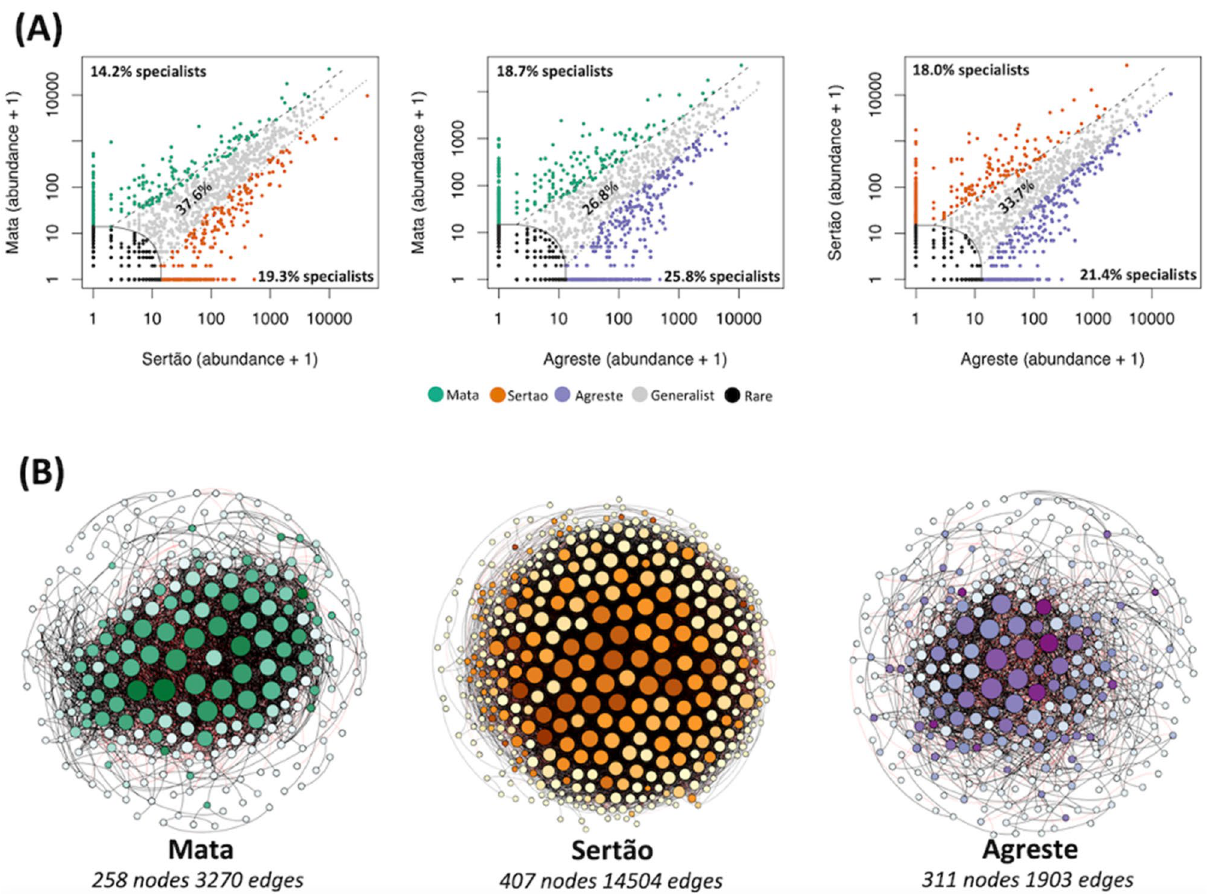
Figure 5. ( A ) Multinomial species classification method (CLAM) for the niche occupancy test based on pairwise comparison. The generalists (gray), specialists (green, orange, and purple), and rare (black) are indicated with their respective percentages. ( B ) Network co-occurrence analysis of the bacterial communities in soils along three distinct ecoregions under cowpea cultivation based on the 16S rRNA gene. A connection stands for SparCC correlation with magnitude > 0.9 (positive correlation–blue edges) or < − 0.9 (negative correlation–red edges) and statistically significant ( P ≤ 0.01). Each node represents taxa at OTU level and the size of node is proportional to the number of connections (that is, degree). The color of the nodes is based on the betweeness centrality, where darker colors indicated higher values. The network construction was made using Gephi